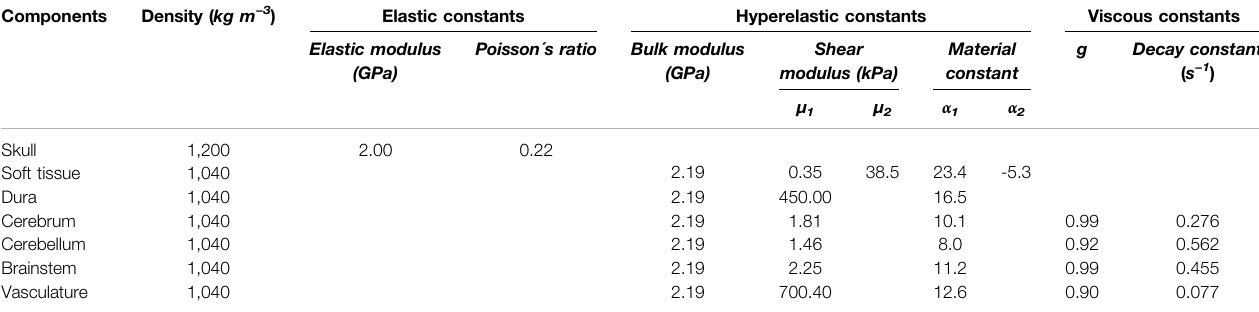
TABLE 1 | Summary of the material properties used for the individual anatomical components included in the high- fi delity minipig-head model.